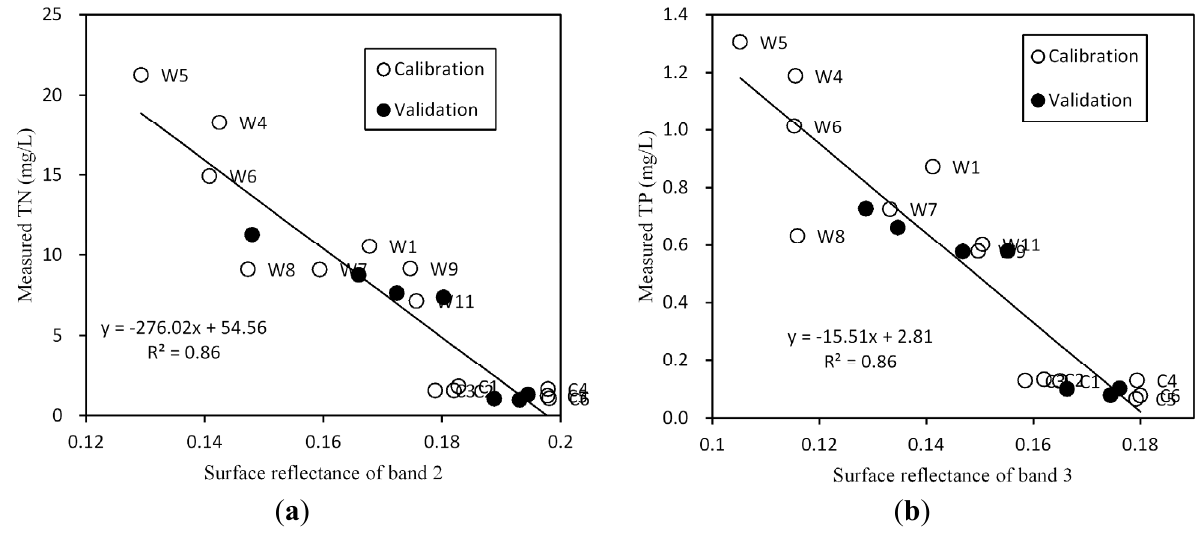
Figure 6. Relationship between surface reflectance of band and measured data predicted ( a ) TN and ( b ) TP concentrations with MLR models.